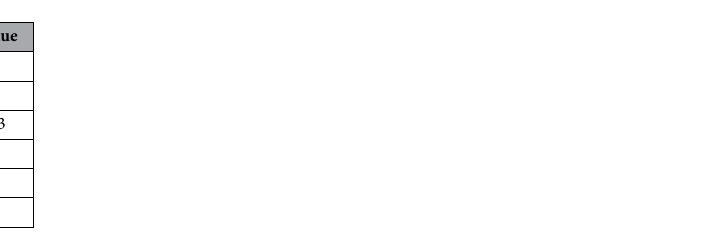
Table 1. The radar system